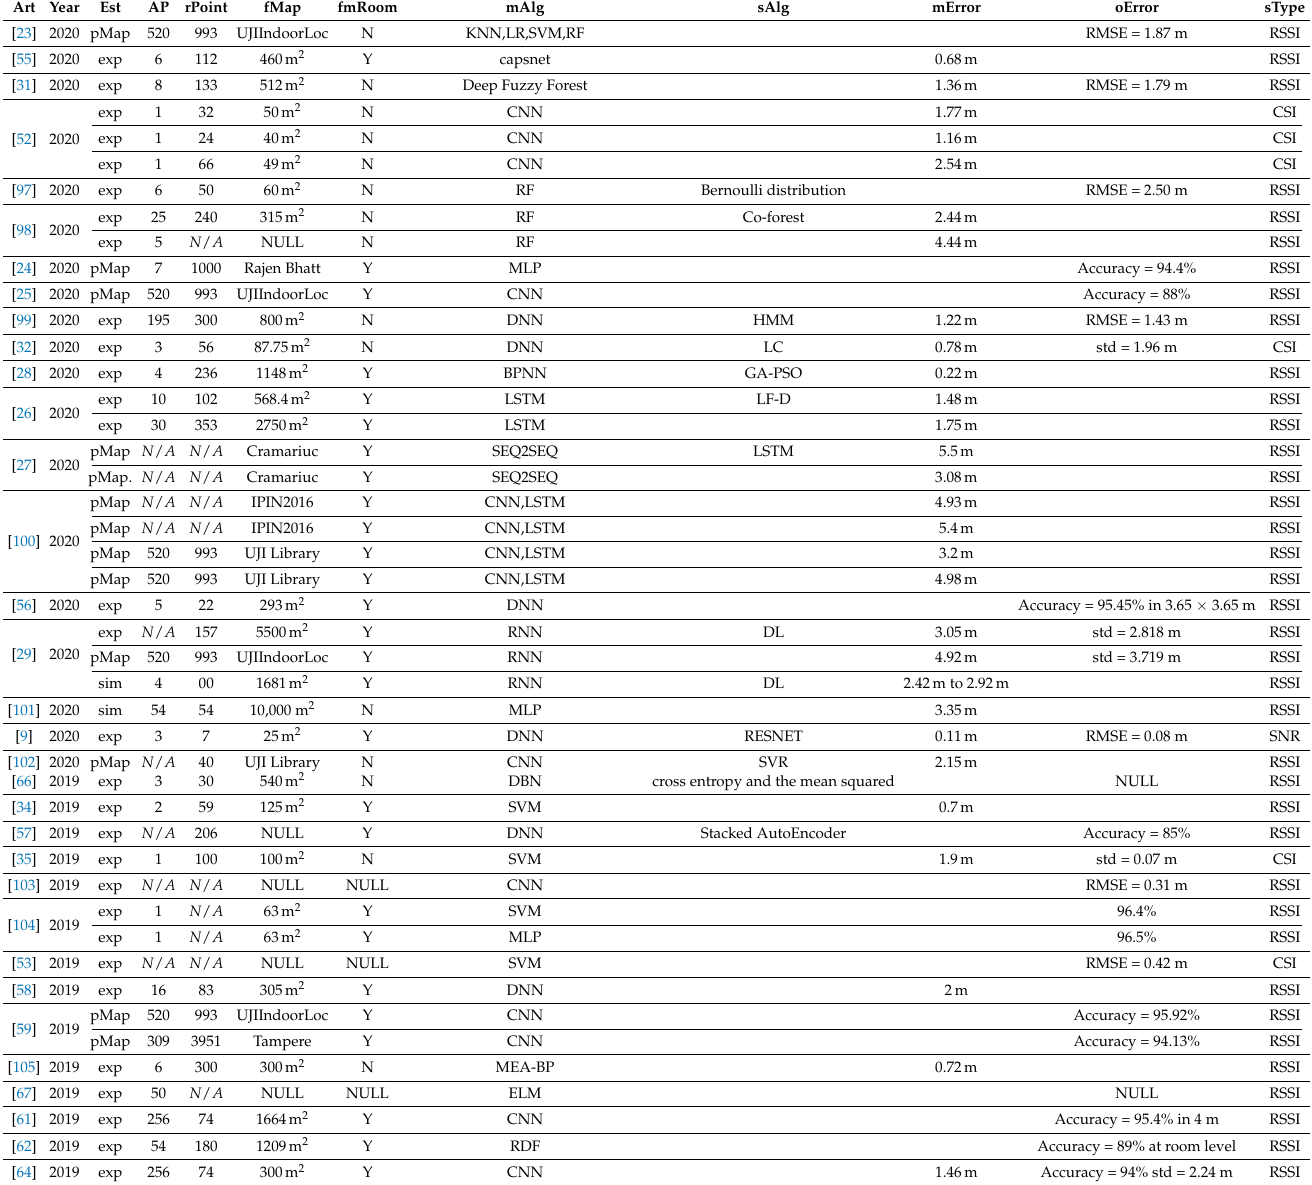
Table A2. Summary of reviewed